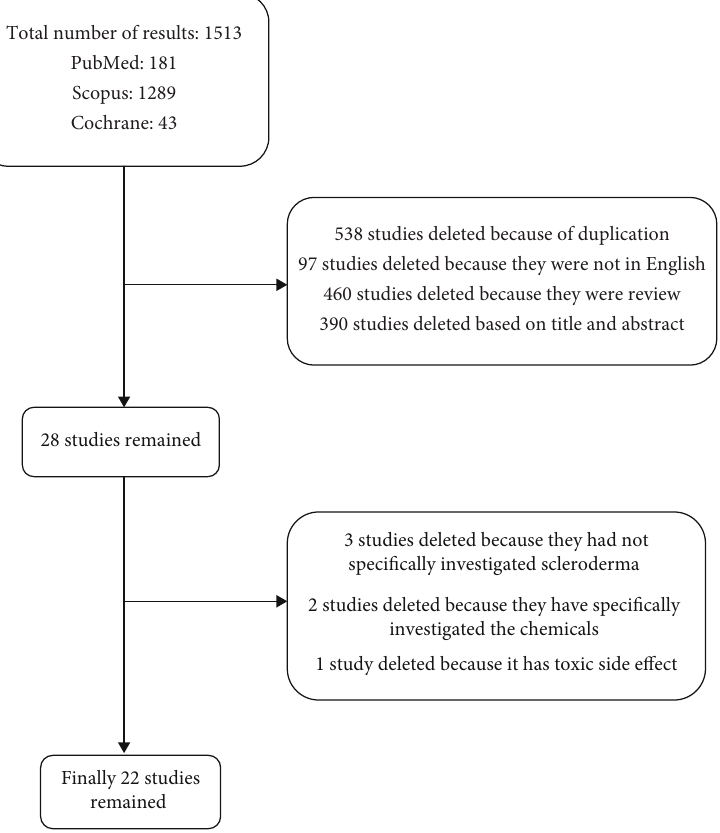
Figure 2: Study design